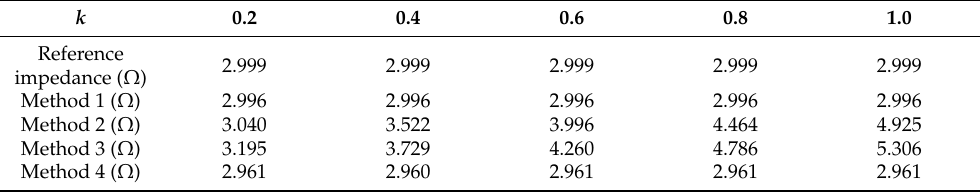
Table 1. Real part average impedance.